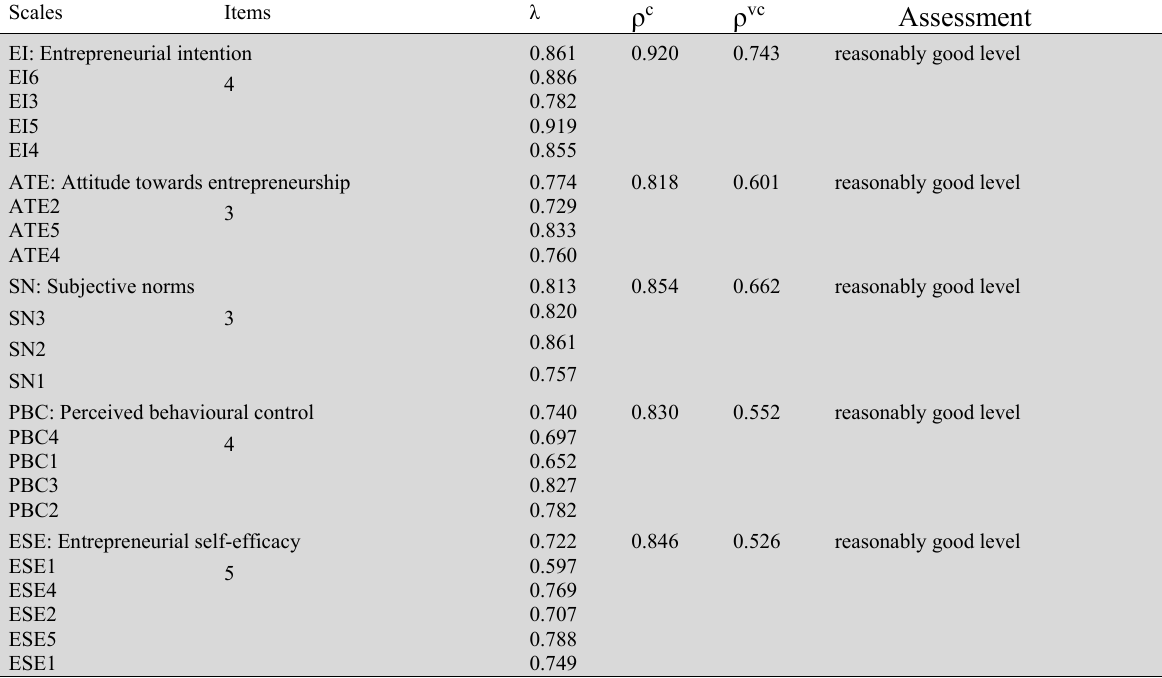
The results of testing the measurement validity by confirmatory factor analysis